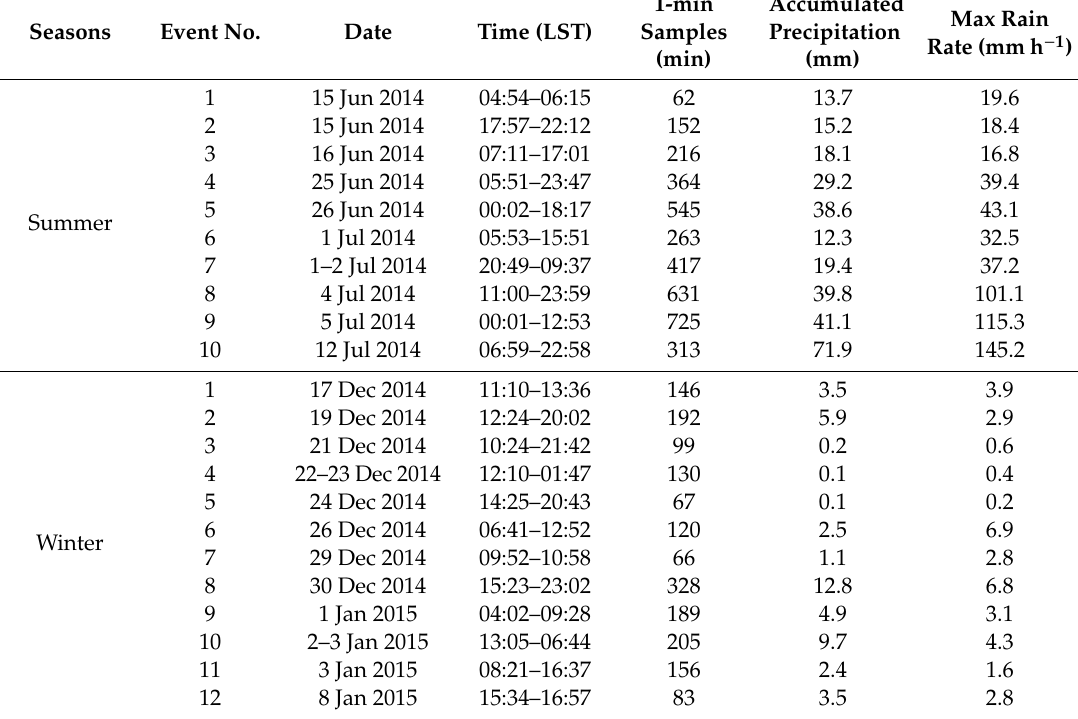
Table 1. Precipitation events used for the present study in two seasons of